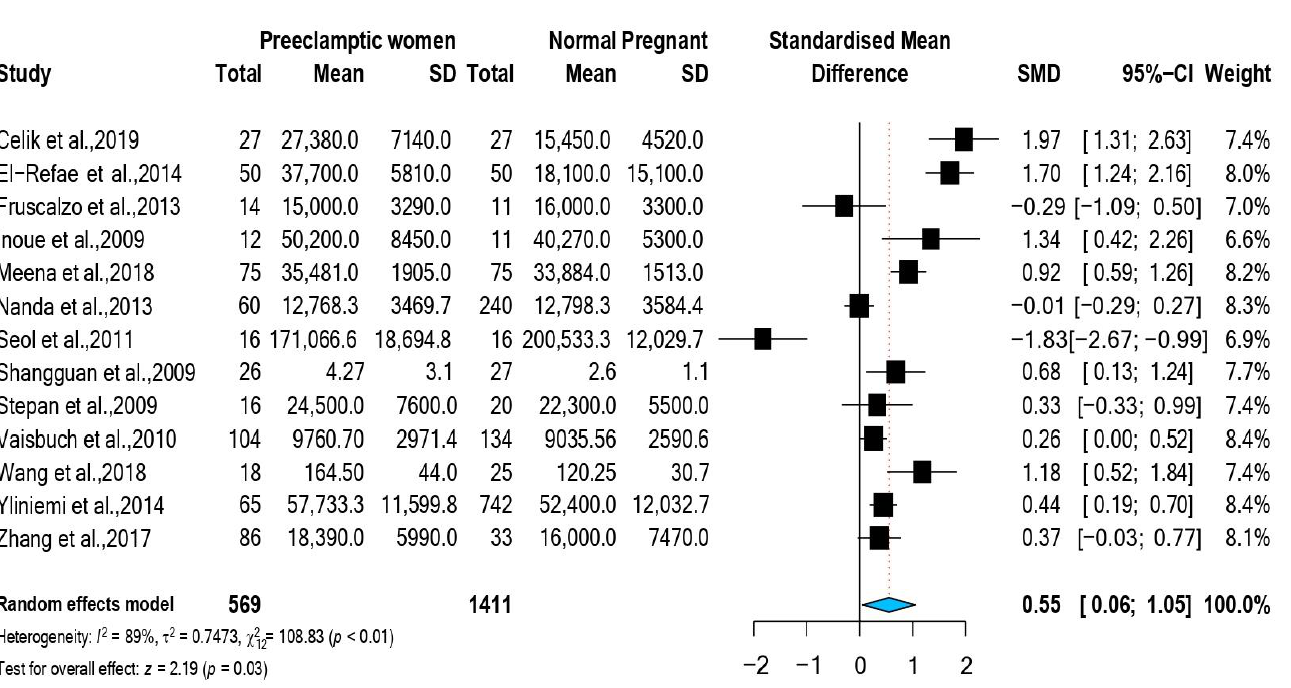
Figure 2. Forest plot for the overall meta-analysis [10 – 19,21 – 23].